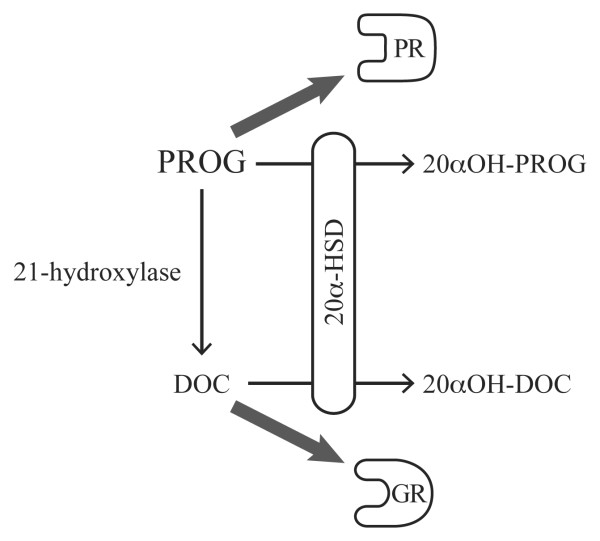
Effects of 21-hydroxylase and 20α-HSD on progesterone receptor and glucocorticoid receptor occupancy. PROG, progesterone; PR progesterone receptor; GR, glucocorticoid receptor.